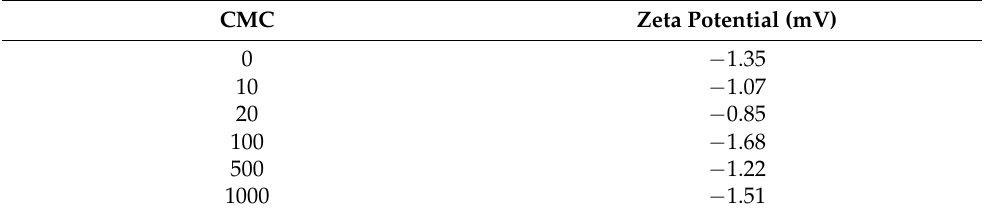
Table 3. Zeta potential analysis of biphasic calcium phosphate prepared by cuttlebone with variation in the CMC of L-rhamnose monohydrate